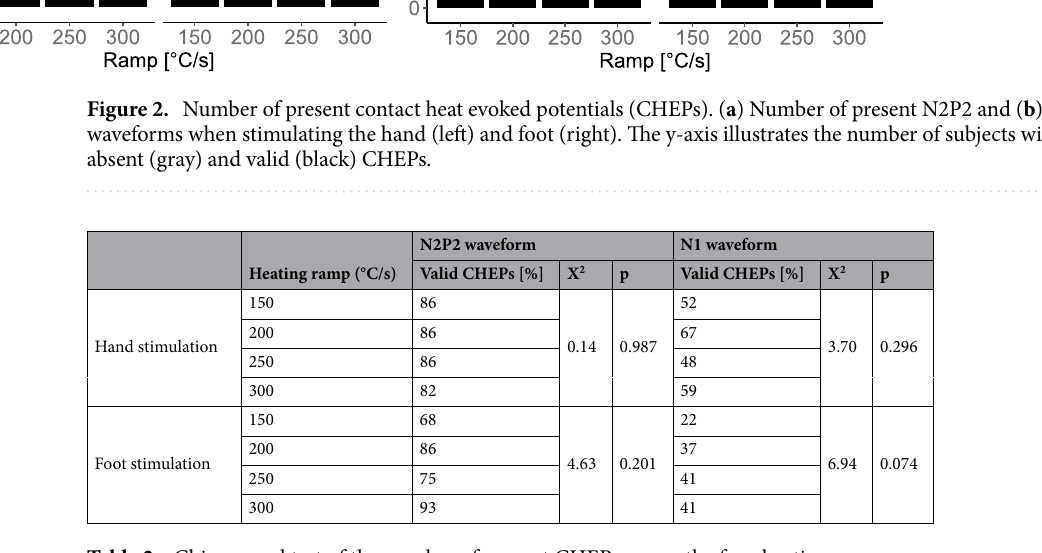
Table 2. Chi-squared test of the number of present CHEPs across the four heating